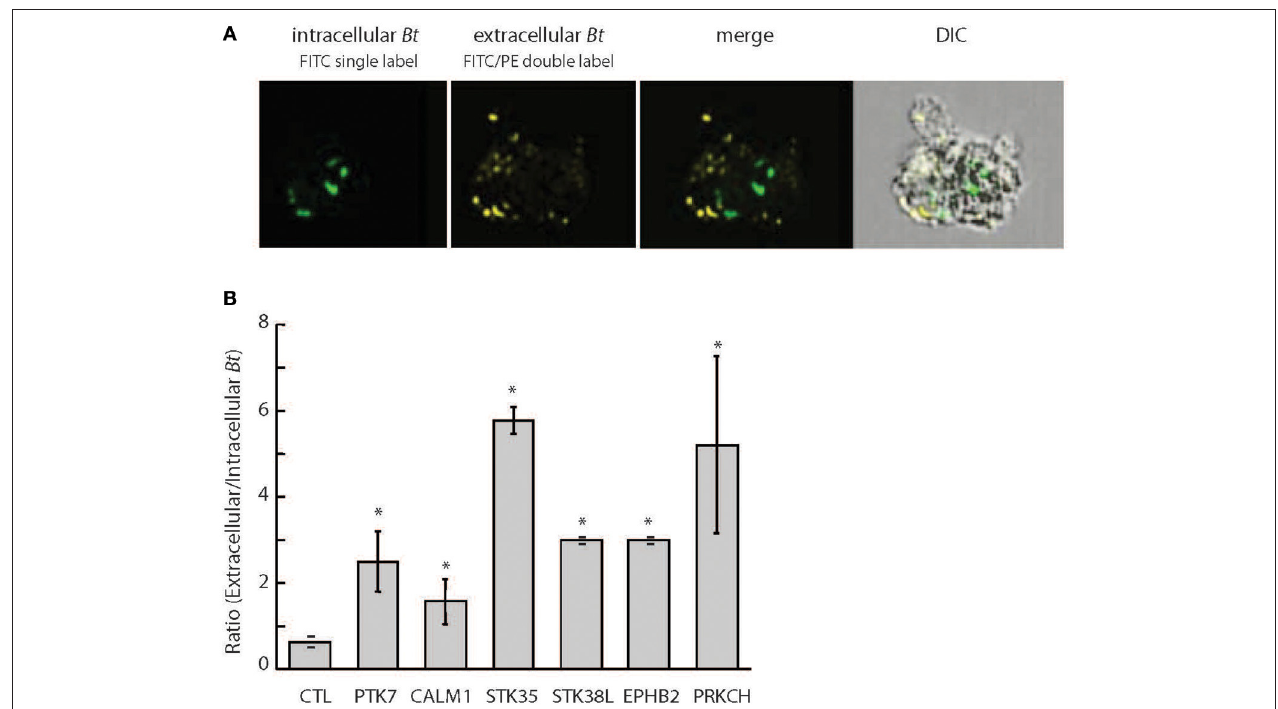
FIGURE 1 | Differential fluorescent labeling of intracellular B. thailandensis upon siRNA knockdown of selected host kinase genes. (A) THP-1 cells pretreated with 50nM siRNA for 72 h were infected with FITC-labeled Bt CDC2721121 for 2 h at MOI 10. Kanamycin (250 µ g/ml) was then added for 3 h to suppress extracellular bacterial growth, after which the infected cells were cultured in antibiotic-free media for 20 h. Bacterial cells remaining extracellular were double-labeled with FITC and B. thailandensis rabbit antiserum/PE-conjugated anti-rabbit IgG, whereas intracellular bacteria were single-labeled with only FITC. Imaging flow cytometry analysis of infected THP-1 cells was performed using the Amnis ImageStream X , and the frequencies of singly and double labeled bacteria were determined using the IDEAS 5.0 software. FITC, fluorescein isothiocyanate (ex495 nm/em519 nm); PE, Phycoerythrin (ex 488 nm/em575 nm). (B) The ratio of extracellular vs. intracellular bacteria in THP-1 cells siRNA-depleted of target kinases was used to evaluate kinase function in intracellular B. thailandensis proliferation. The average and standard deviation were determined from three independent experiments (Supplementary Table 2). The “*” denotes statistical significance ( p < 0.05) for the ratio of extracellular to intracellular pathogen in cells siRNA-depleted of target gene compared to cells treated with control